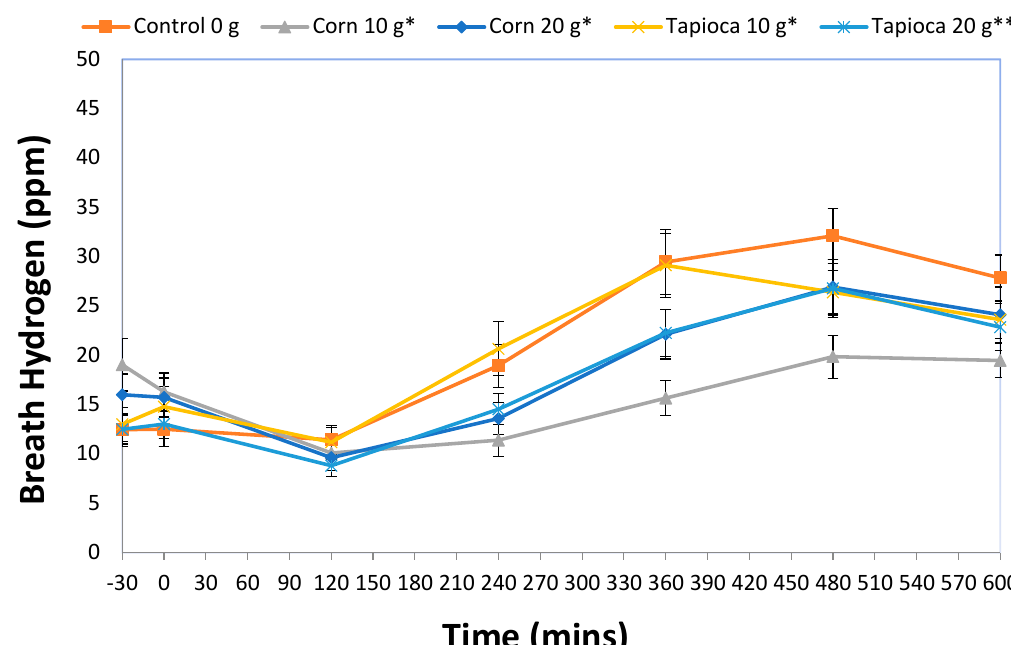
Figure 1. Mean ± standard error (SE) for breath hydrogen rated through 600 min. * Indicates statistical significance from control ( p < 0.05). ** Indicates statistical significance from both Corn10 and Tapioca10 treatments ( p < 0.05).